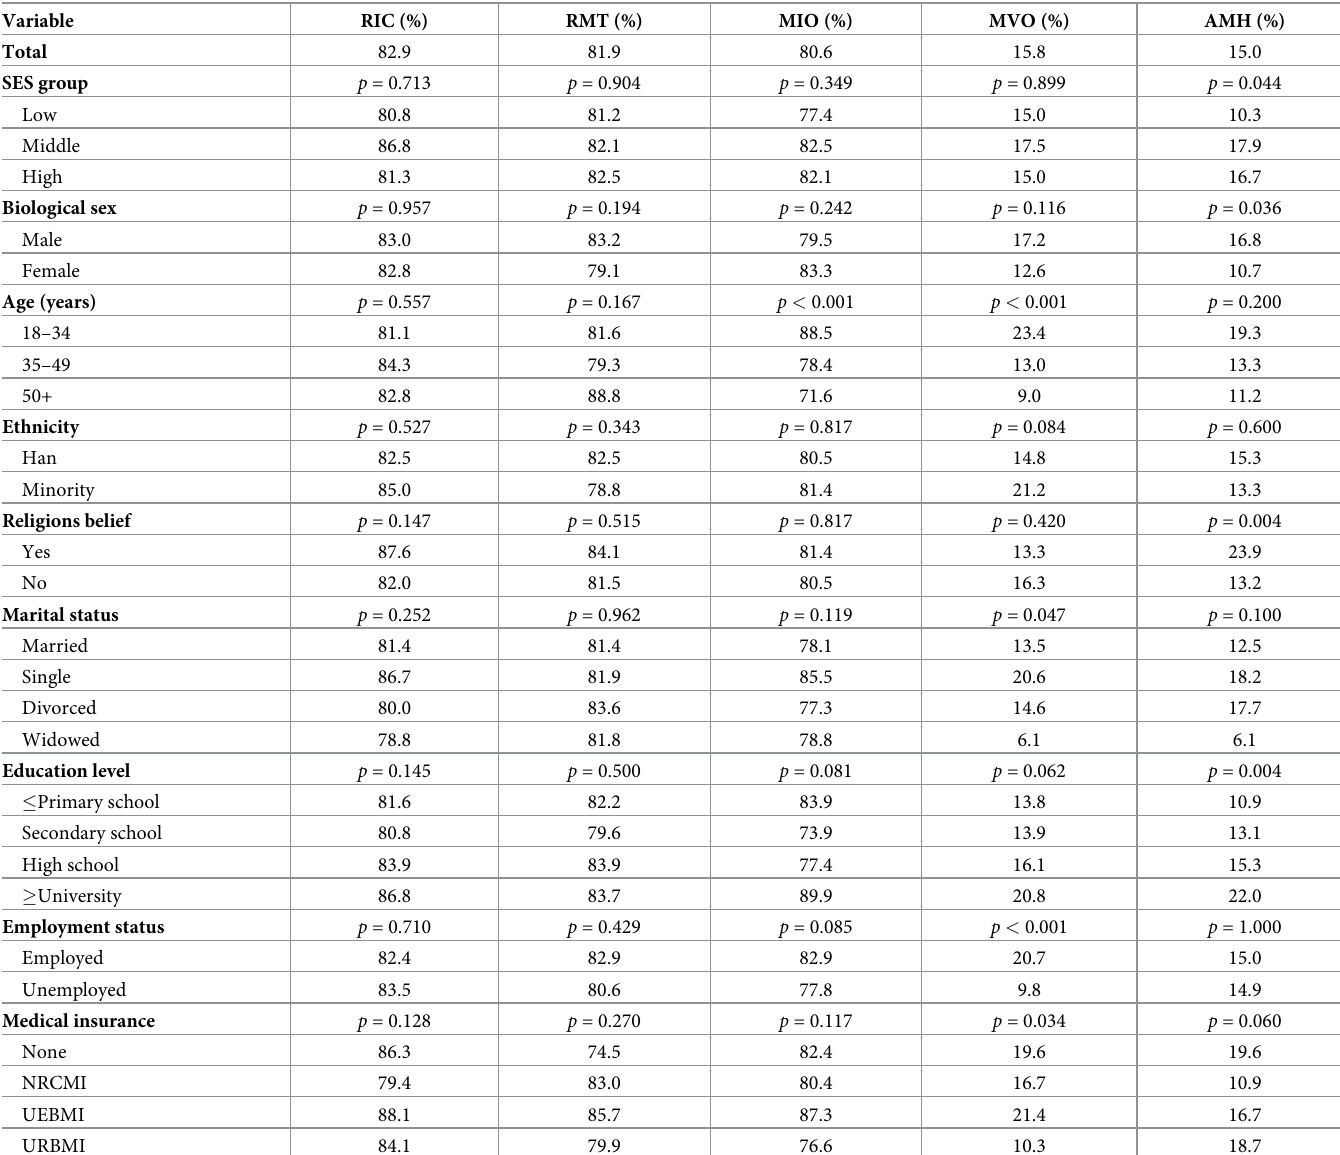
Table 2. Distribution of complete uptake of HIV continuous care by socio-demographic